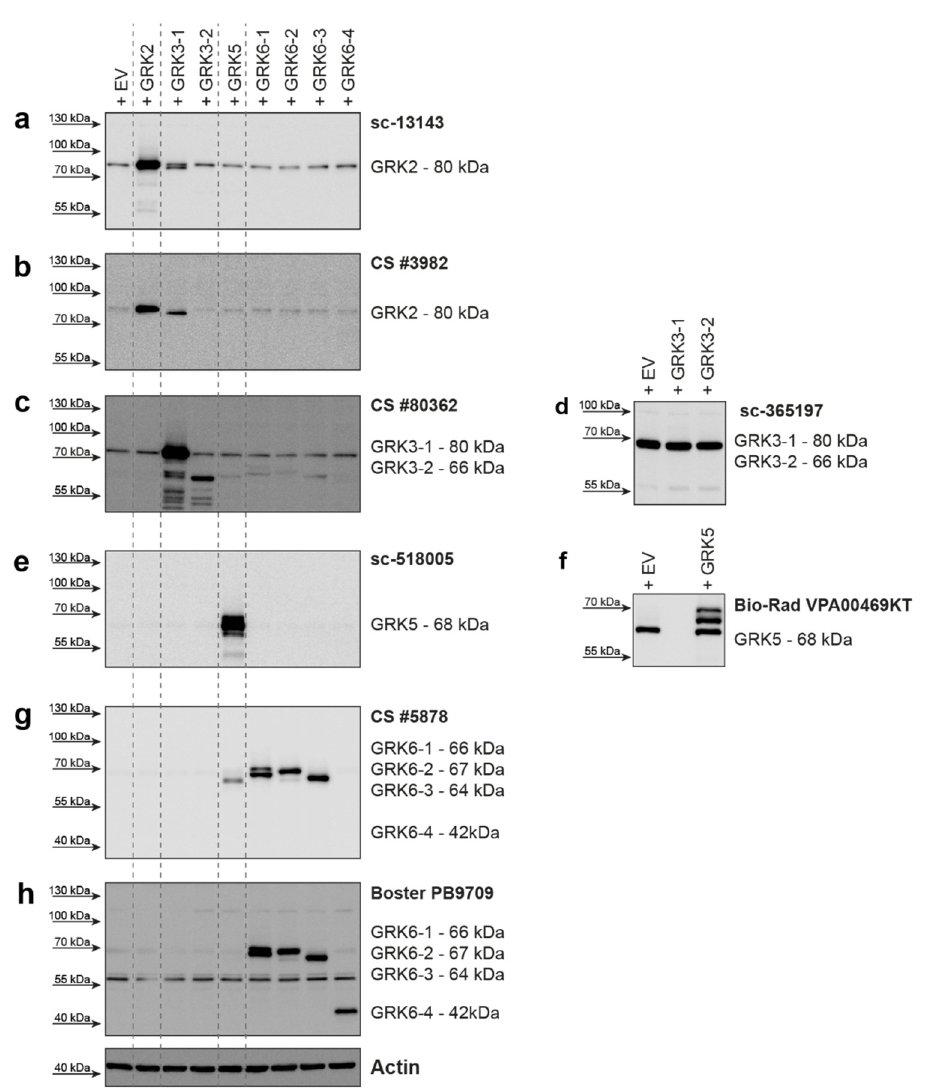
Figure 1. GRK isoform specificity of several commercially available GRK antibodies. HEK293 cells were transiently transfected with pcDNA3 plasmids encoding either GRK2, GRK3-1, GRK3-2, GRK5, GRK6-1, GRK6-2, GRK6-3, or GRK6-4 as indicated. GRK isoform specificity of indicated GRK antibodies was investigated in Western blot analysis. Representative blots are shown. Two different antibodies raised against GRK2 ( a , b ), GRK3 ( c , d ), GRK5 ( e , f ), and GRK6 ( g , h ) were used for the analysis. Approximate molecular weight of each antigen is stated. Detailed information on each antibody examined is listed in Table 1. Actin served as loading control.